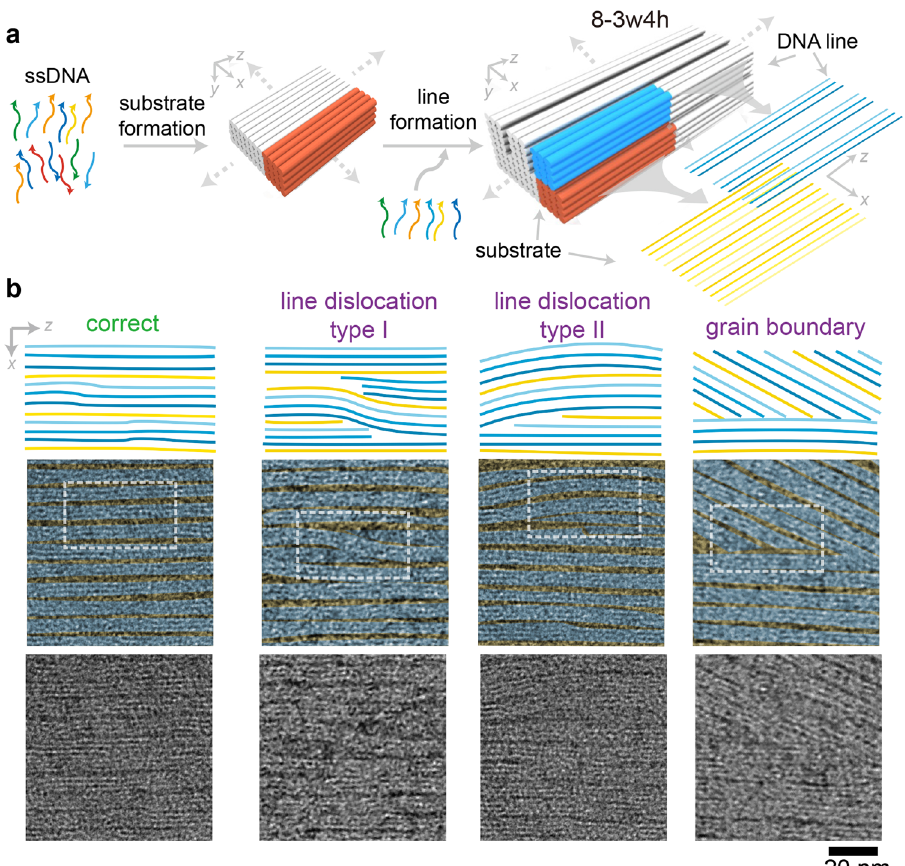
Fig. 1 High-dimensional crystallographic defects of 8-3w4h. a Assembly pathway for the DNA line arrays. The orange and the blue bundles represent the substrate and the line modules in one repeating unit cell, respectively. The dashed arrows indicate the lattice extension directions. The gradient colored lines correspond to the helical orientations of the DNA lattices. Speci fi cally, yellow gradient colors denote the lattice orientations of the heterogeneous sequenced substrate module; blue gradient colors denote the lattice orientations of the heterogeneous sequenced line module. In 8-3w4h, 8 denotes the line pitch along the x direction, 3w denotes the 3 layers of helices for DNA line along the x direction, and 4h denotes the 4 layers of helices for DNA line along the y direction. b Schematics and TEM images for the representative assembly morphologies at 8.2 nm line pitch along the x direction. From left to right, the morphologies of the correctly assembled lines, type I line dislocation, type II line dislocation, and grain boundary. Each lane corresponds to one speci fi c assembly morphology. Top, line schematics along the x - z projection plane. Middle, fake-colored TEM images. Yellow and blue colors denote the space and line regions, respectively. White dashed boxes indicate the schematic area in the top row. Bottom, raw TEM images. The scale bar is 20 numbers changed, the line dislocations were categorized into type I (unchanged) or type II (changed).